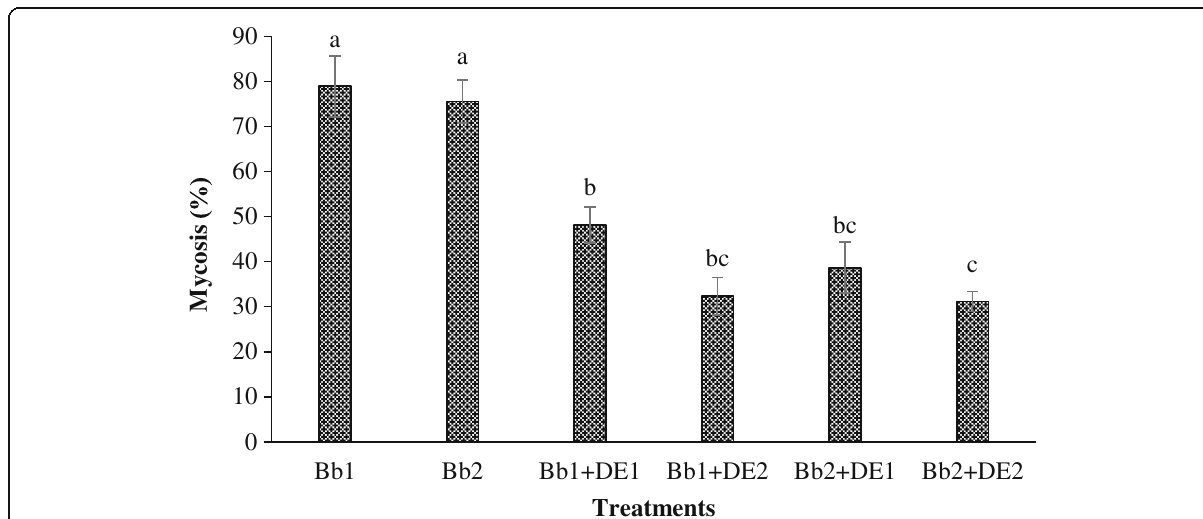
Fig. 2 Percent mycosis (mean ± SE, n = 3) in cadavers of Tribolium castaneum treated with two concentrations of Beauveria bassiana (1 × 10 6 and 1 × 10 8 conidia kg − 1 of wheat) alone and mixed with